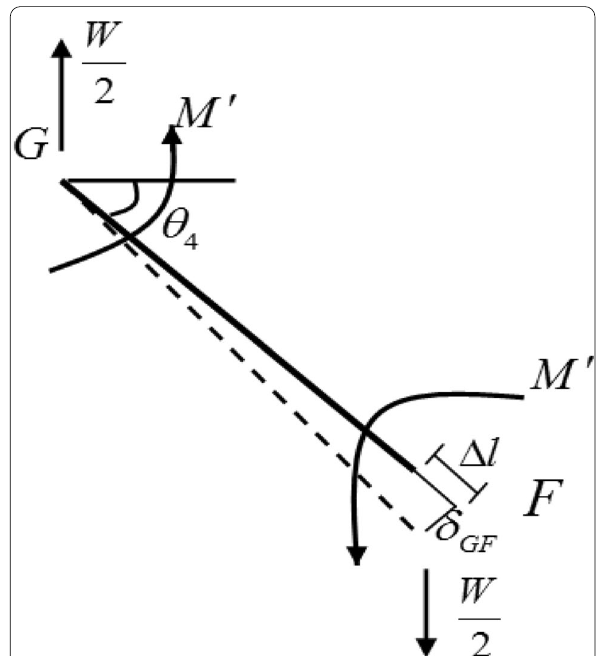
Figure 6 Force analysis of rod